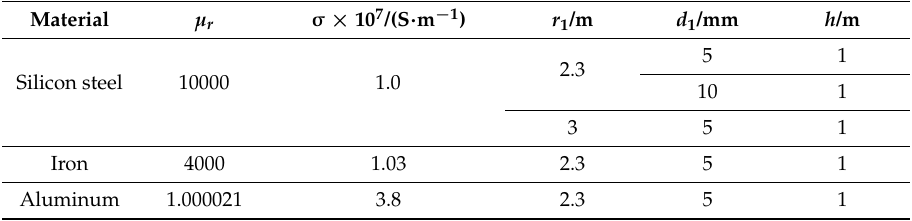
Table 3. Parameters of shielding